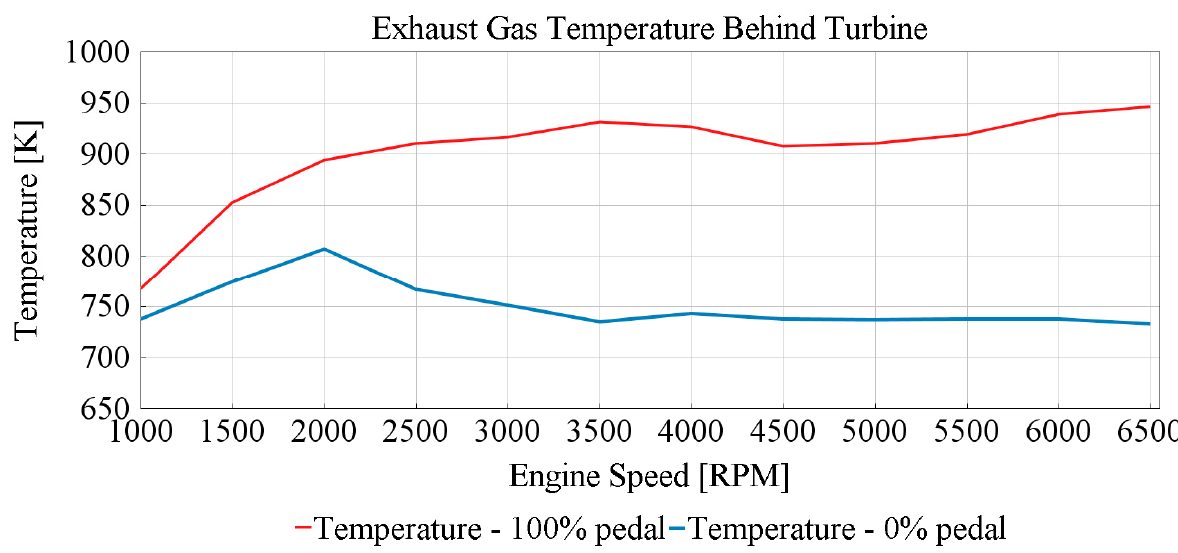
Figure 7. Exhaust gas temperature under steady-state conditions 100% and 0% accelerator pedal position.